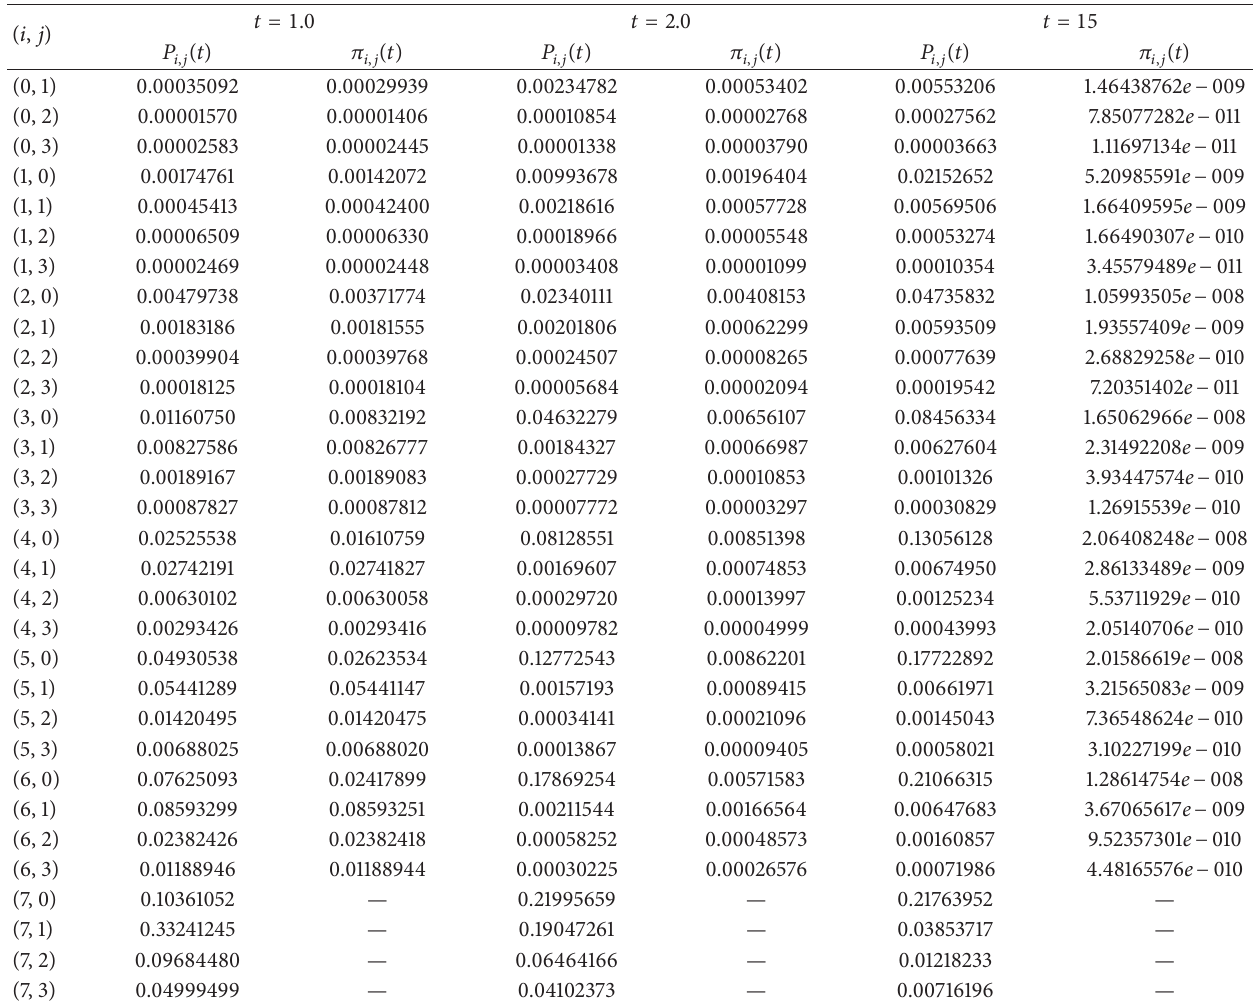
Table 2: State probabilities at time 𝑡 for 7-out-of-13: 𝐺 system with Coxian vacation time distribution.